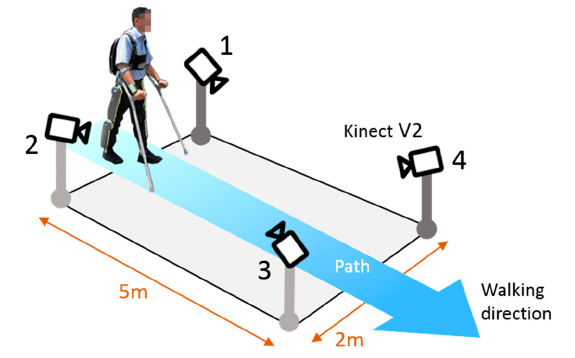
Figure 1. Orientation of the 4 Kinects in the measurement area, and direction of the walking.